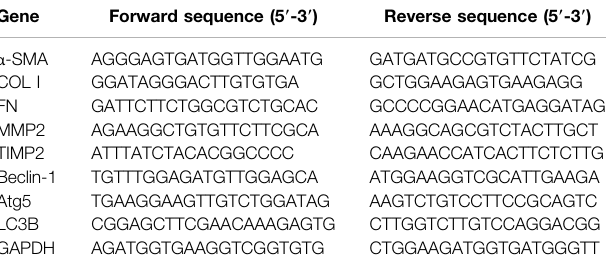
TABLE 2 | Primer sequences used for RT-PCR analysis. Gene Forward sequence (5 9 -3 9